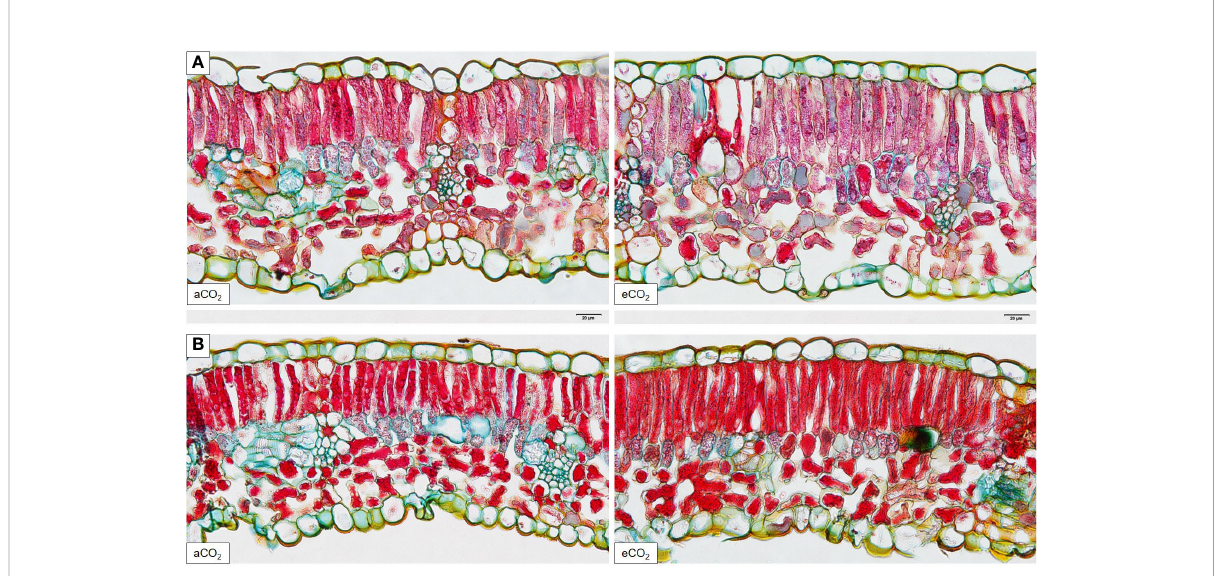
FIGURE 3 Histological analysis of aCO 2 and eCO 2 leaf cross-sections of Vitis vinifera cvs. Cabernet Sauvignon (A) and Riesling (B) stained with W3A (20 m m, 400x).